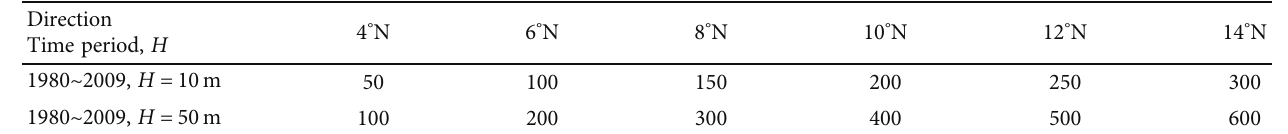
Table 6: Distribution of wind power density (W/m 2 ).